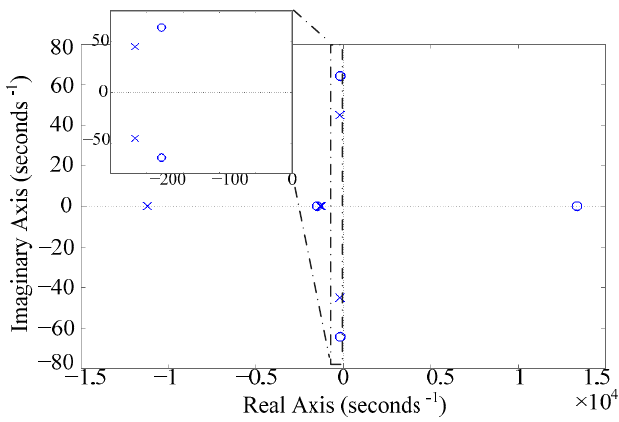
Table 1. System and control parameters.